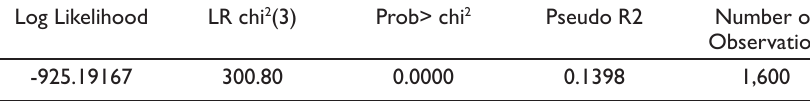
Table 10. Model Filling Information for Rental Housing in Delhi